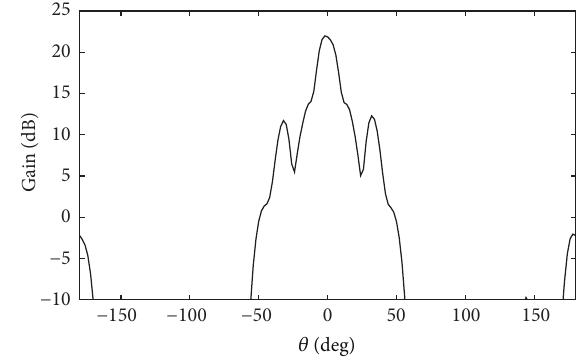
Figure 7: Simulated gain in 𝑥𝑧 plane at 5.85 GHz.